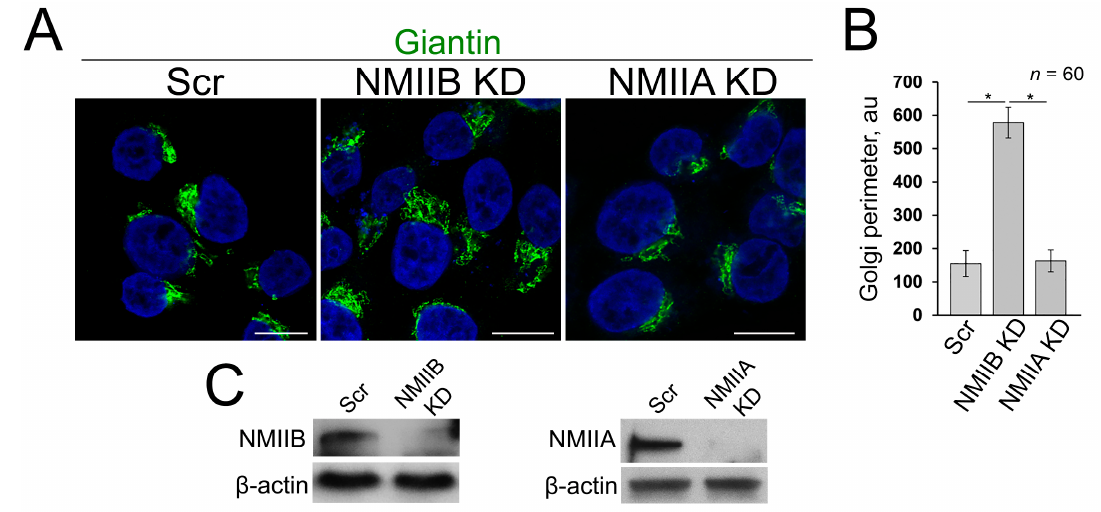
Figure 4. ( A ) Confocal immunofluorescence images of Golgi (giantin) in VA-13 cells: treated with scramble, NMIIB or NMIIA siRNAs; bars, 10 µ m; ( B ) Quantification of Golgi perimeter from cells presented in ( A ); n = 60 cells from three independent experiments, results expressed as a mean ± SD; * p < 0.001; ( C ) NMIIB (left panel) and NMIIA (right panel) W-B of lysates of VA-13 cells treated with corresponding siRNAs; β -actin was a loading control.